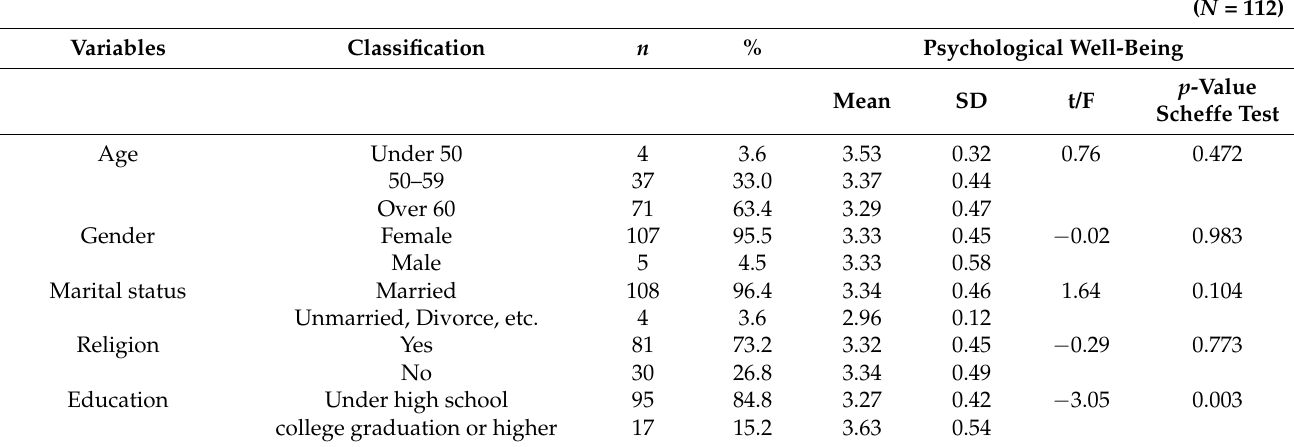
Table 1. Sociodemographic and working-related information of the participants and differences in psychological well-being according to general